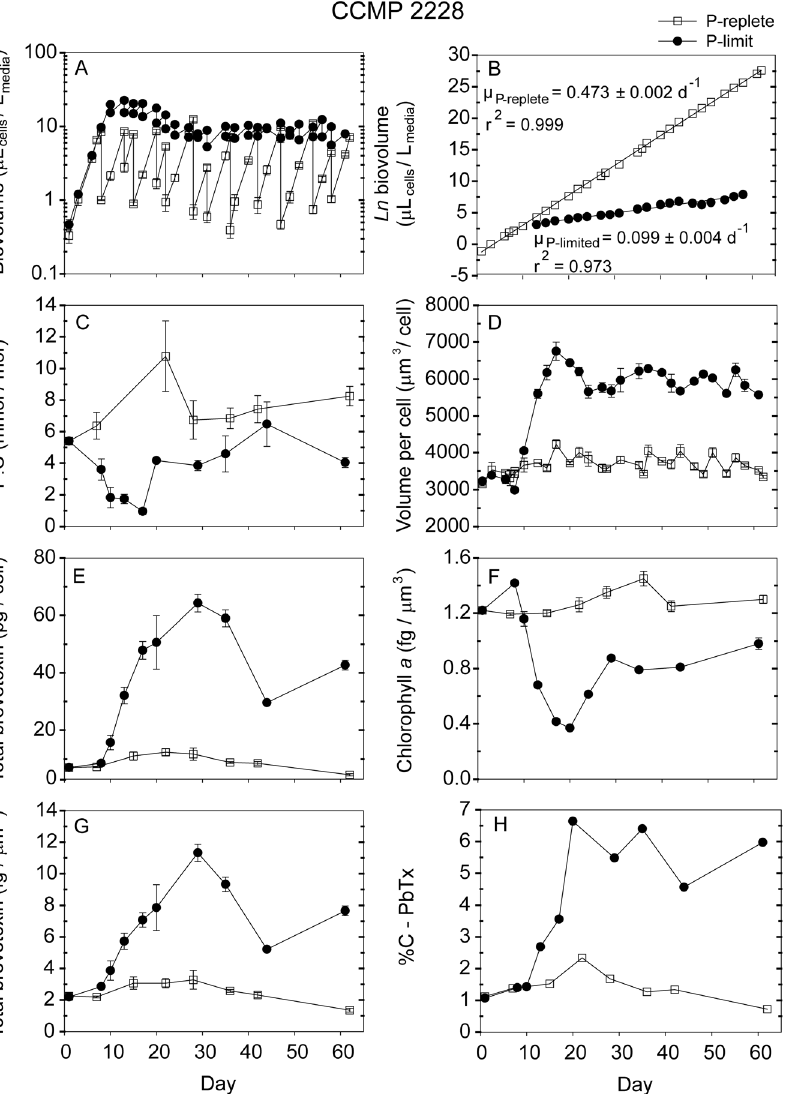
Figure 1. Time-dependent results for semi-continuous batch cultures of Kareniabrevis strain CCMP 2228 grown at nutrient-replete rates in high-P media (open squares) and grown into P-limitation in low-P media (filled circles). (A) Biovolume ( m L cells /L media ) plotted on a log scale vs. time, (B) Natural logarithm (ln) biovolume vs. time, correcting for culture dilution [39], (C) Cellular phosphorus to carbon molar ratios (mmol/mol), (D) Mean volume per cell ( m m 3 /cell), (E) Total brevetoxins per cell (pg/cell), (F) Chlorophyll a normalized to cell volume (fg/ m m 3 ), (G) Total brevetoxins normalized to cell volume (fg/ m m 3 ), (H) Percent of cellular carbon associated with brevetoxins (%C-PbTx). Error bars represent the standard deviation of triplicate measurements, except those normalized to carbon, where the cellular C was measured only in